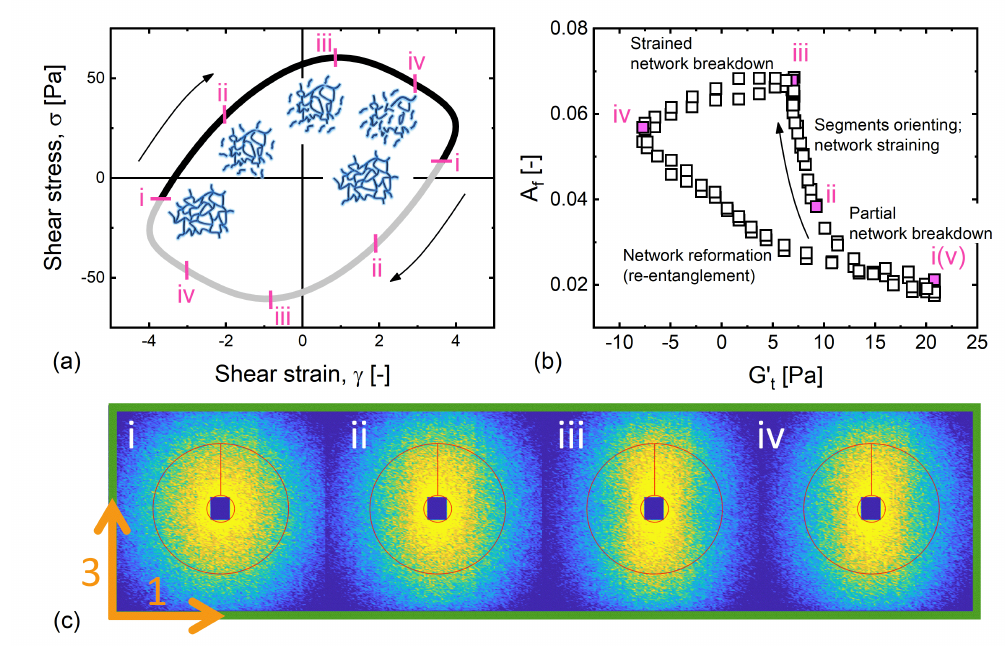
Figure 7. The microstructural evolution during the course of oscillation at De = 1.66. The structure evolves in a sequence: network partially disentangling and broken in stages i–ii, Kuhn segments aligning with the rest of network being strained in stages ii–iii, orientation slightly diminishing in stages iii–iv due to decreasing shear rate, and Kuhn segments re-entangling to reform initial network in stages iv–v. ( a ) Shear stress versus shear strain. ( b ) The degree of alignment is plotted as a function of time-dependent elastic modulus. ( c ) 2D SANS patterns in the corresponding stages during a LAOS